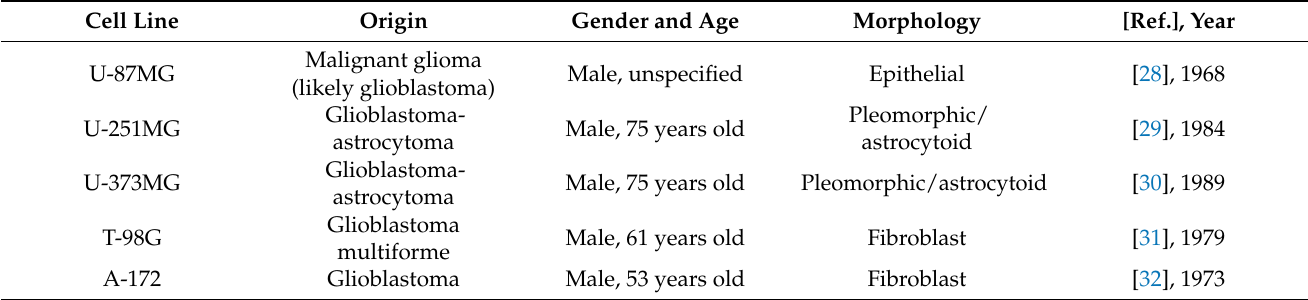
Table 1. Characteristics of the most common glioblastoma cell lines and year first cited.